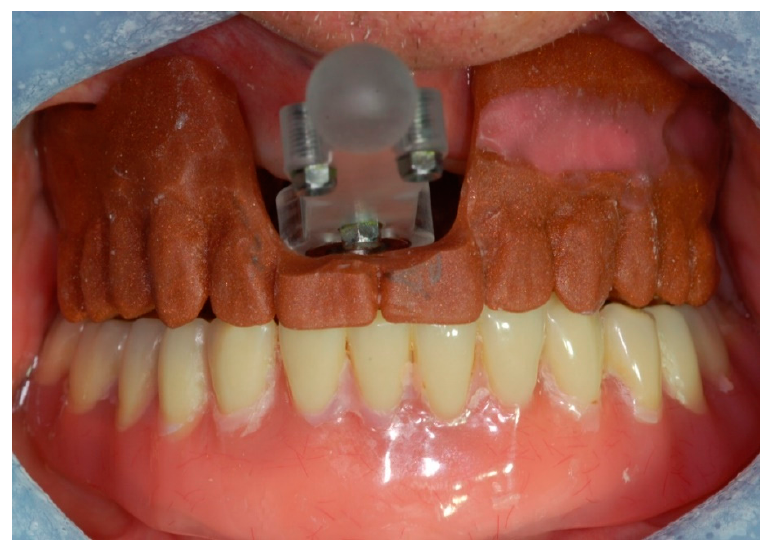
Figure 2. The markers plate and the radiographic template placed in situ for the CBCT.